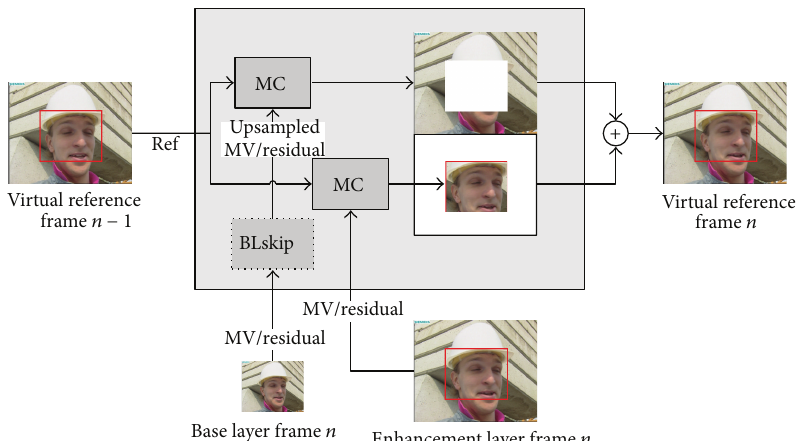
Figure 4: Generation of virtual reference frame 𝑛